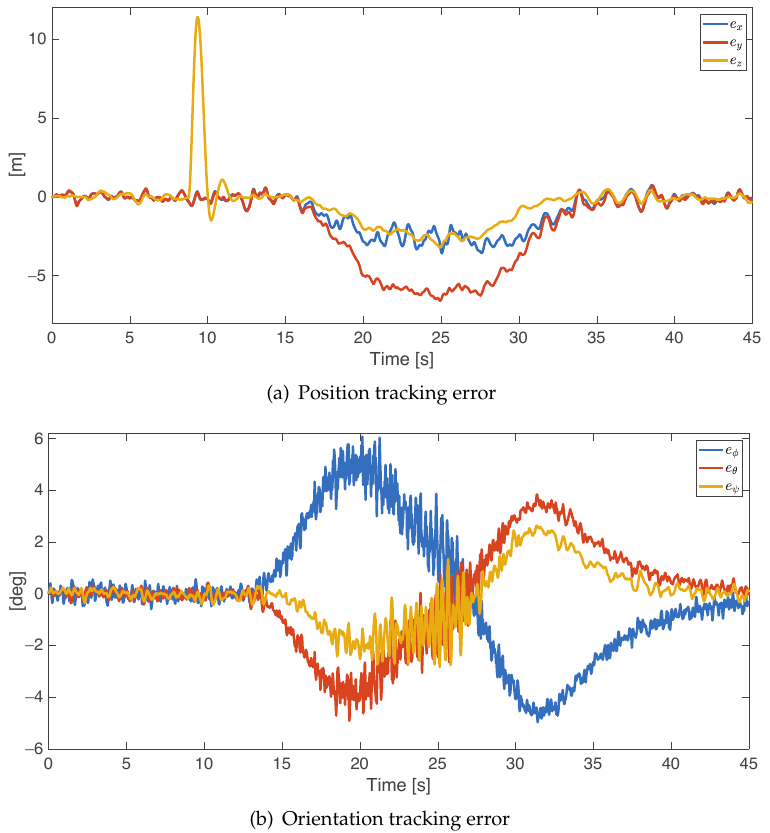
Figure 7. Second case study: platform position and orientation tracking